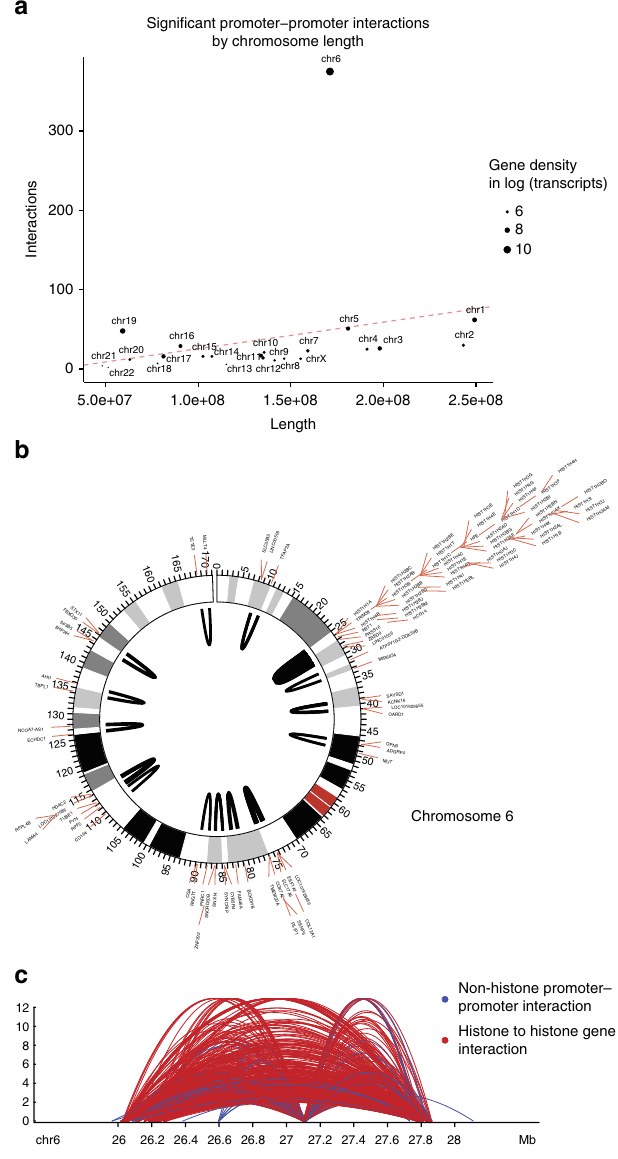
Figure 4 | Long-range promoter–promoter interactions are enriched at the histone locus on chromosome 6. ( a ) Number of significant long-range (1.5—2Mb) promoter–promoter interactions per chromosome plotted versus chromosome length, showing striking enrichment of such interactions on chromosome 6. ( b ) Circos plot of long-range (1.5–2Mb) promoter–promoter interactions on chromosome 6. Opacity of arcs indicates density of Hi-C contacts, showing a cluster of interactions at the histone locus. ( c ) Significant promoter–promoter interactions linking histone gene pairs (red arcs) or non-histone gene pairs (blue arcs) at the histone locus on chromosome